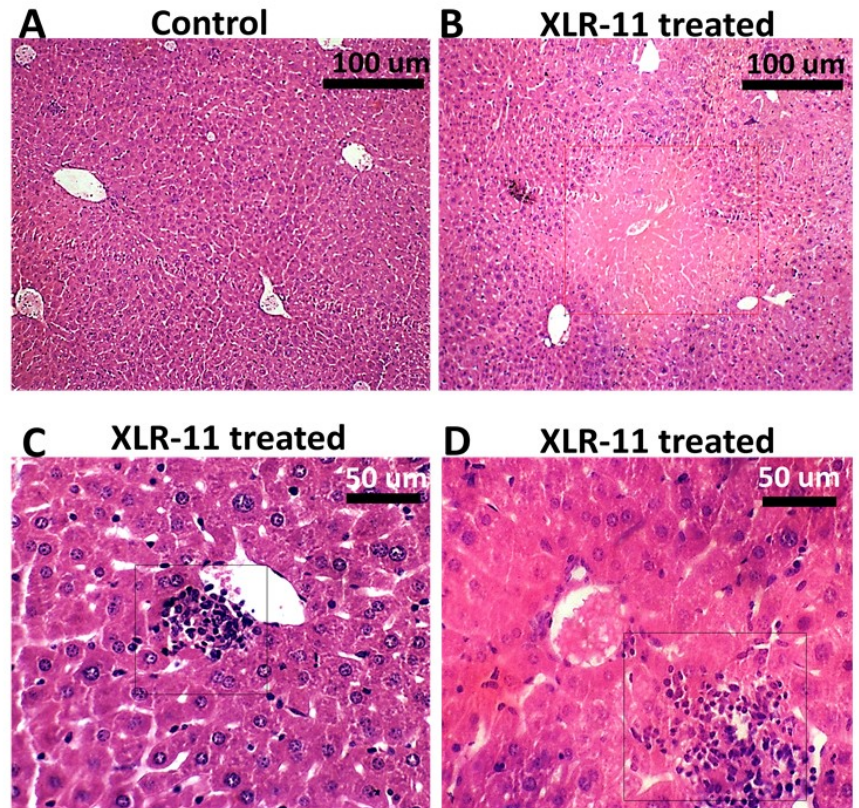
Figure 4. Histopathology of the liver from control mice ( A ) and XLR-11 treated mice ( B – D ). Red square box indicates centrilobular necrosis, black square boxes indicate spotty necrosis associated with lymphocytic infiltrate.